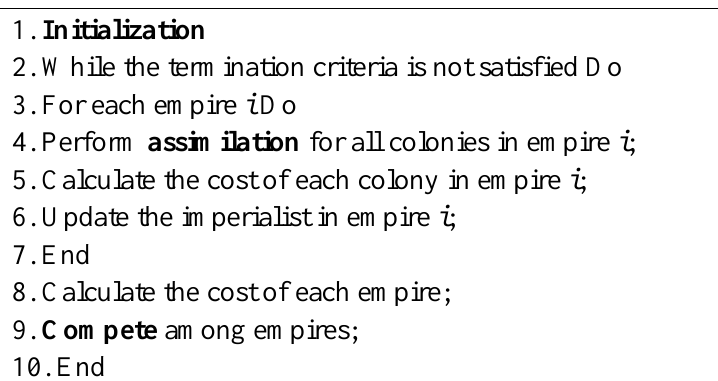
Figure 1. The original Imperialist Competitive Algorithm (ICA)